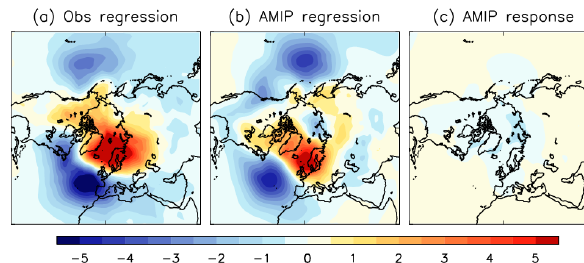
Figure 4. Inability to diagnose atmospheric response to sea ice from observations alone. Linear regression between autumn (September– November) Arctic sea ice extent and winter (December–February) mean sea level pressure (reversed sign) in (a) observations and (b) atmosphere model experiments forced by observed SIC and SST following the Atmosphere Model Intercomparison Project (AMIP) protocol. All time series were linearly detrended and cover the period December 1979 to November 2009. (c) Winter mean sea level response to reduced sea ice in atmospheric model experiments (scaled by the average autumn sea ice extent reduction). Units are hPa per million km 2 . Source: Smith et al.